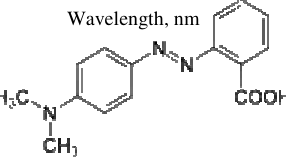
Figure 2. Structure of methyl